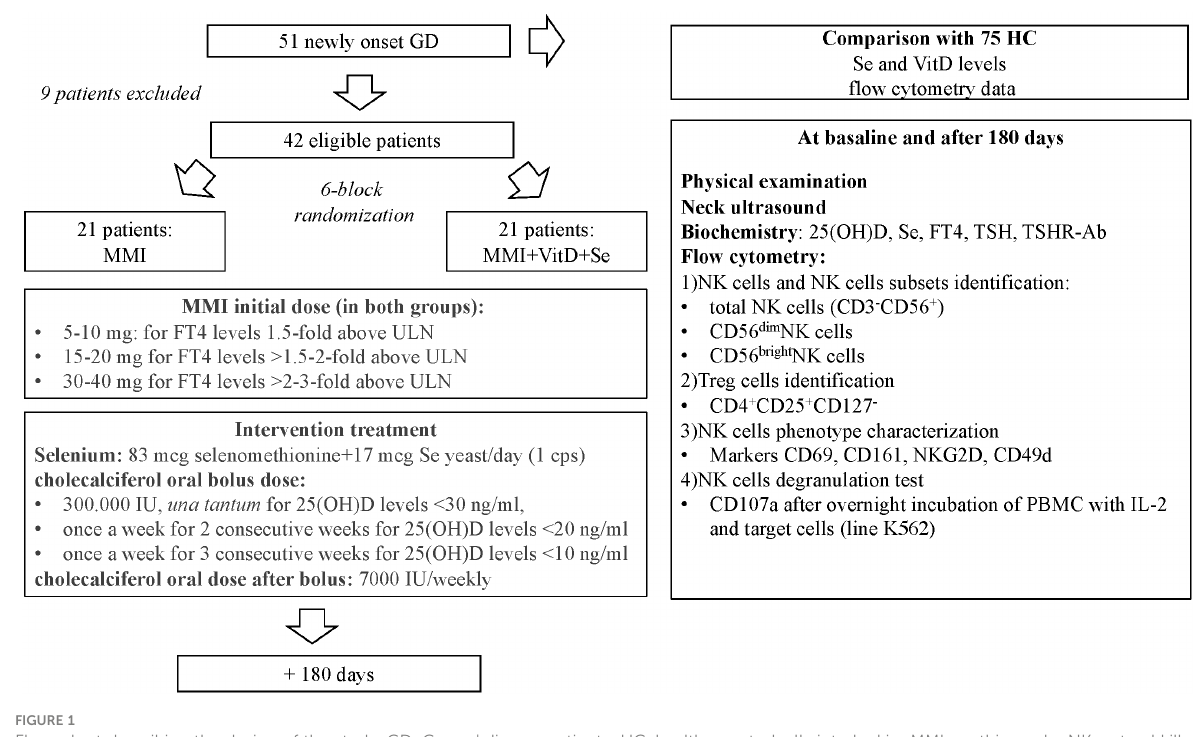
FIGURE 1 Flow-chart describing the design of the study. GD, Graves' disease patients; HC, healthy controls; IL, interleukin; MMI, methimazole; NK, natural killer cells; PBMC, peripheral blood mononuclear cells; Se, selenium; Treg, T regulatory cells; TSHR-Ab, TSH receptor antibodies; ULN, upper limit of normal; VitD, vitamin D levels; 25(OH)D,